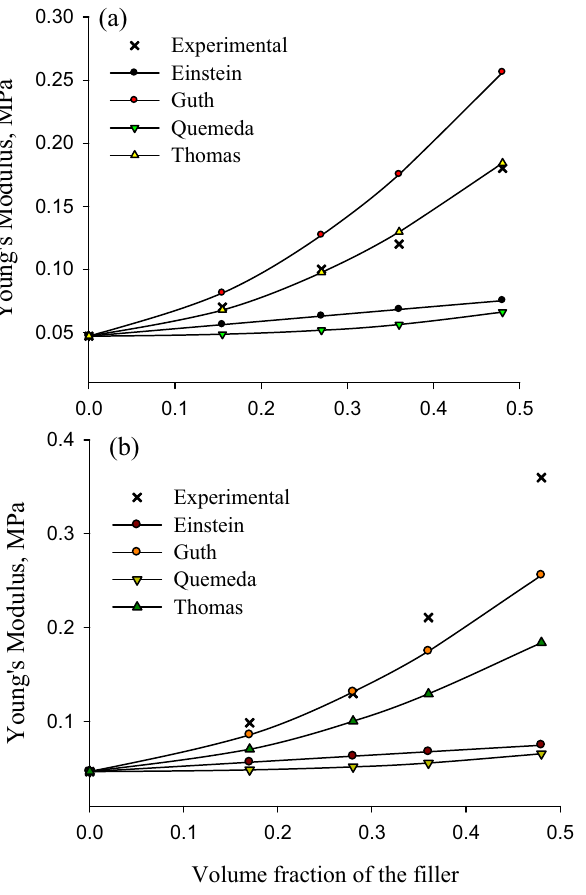
Figure 5: ( a ) Theoretical and experimental values of Young ’ s mod - ulus of CB - loaded NR/IIR blends and ( b ) the e ff ect of TCNP loading.